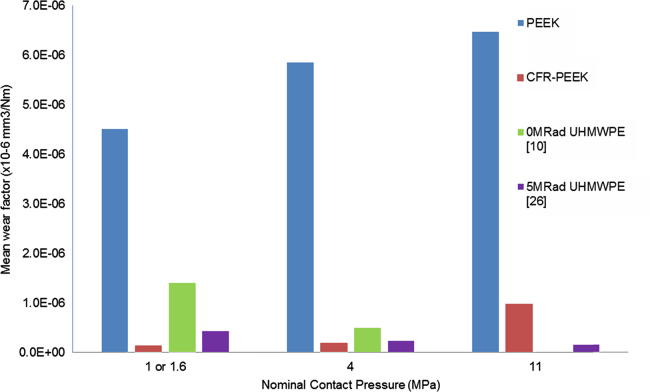
Comparison of wear factors with existing literature for UHMWPE (note previous studies were conducted at 1 MPa (Kang et al., 2008; Abdelgaied et al., 2013).